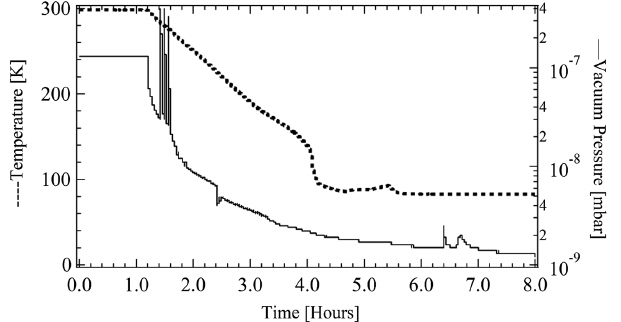
FIG. 11. Cooling down of the cryogenic undulator. (Normal line) Undulator vacuum pressure, (dashed line) permanent magnets temperature.